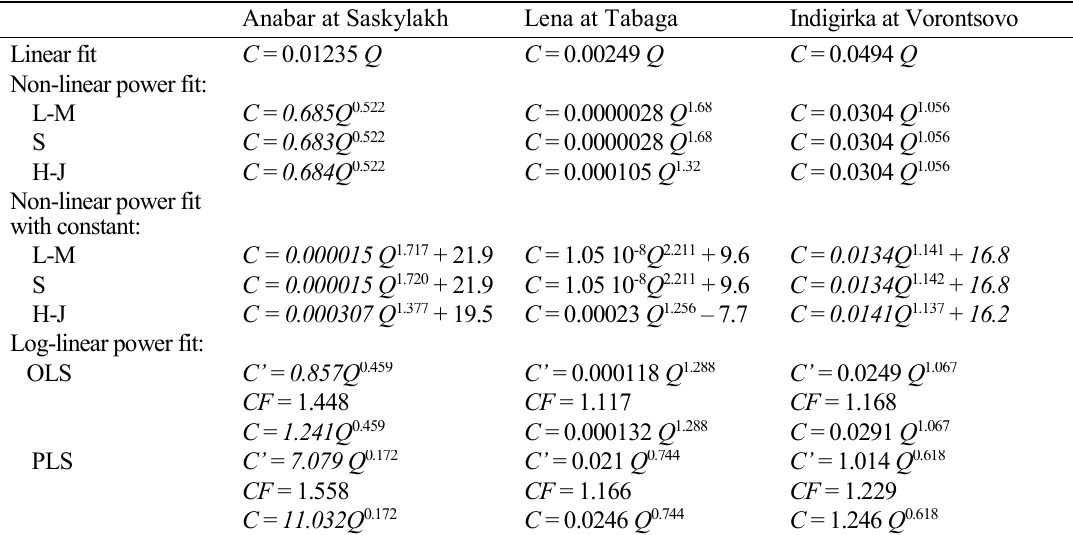
Table 3 Sediment rating curve equations for the Russian Arctic study rivers. Anabar at Saskylakh Lena at Tabaga Indigirka at